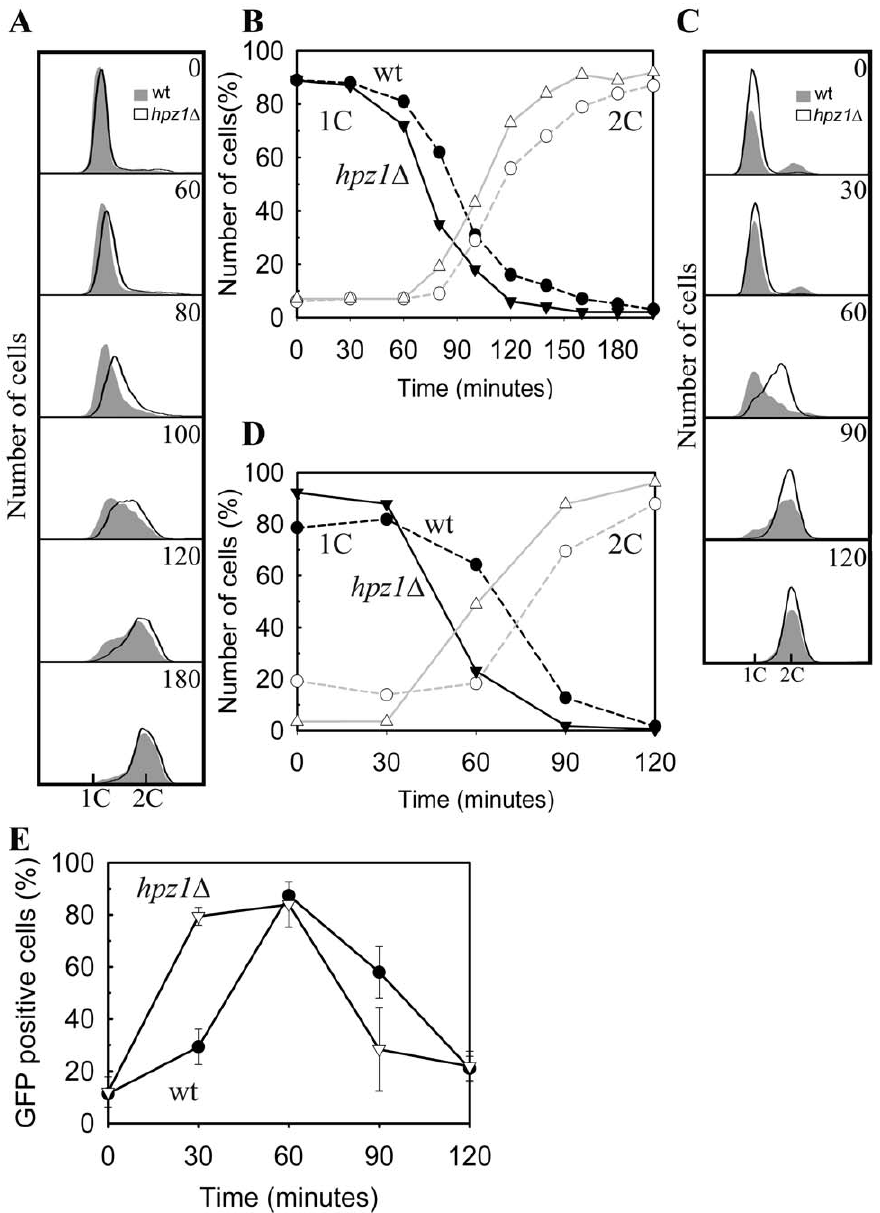
Figure 3. Progression of DNA replication. Analysis of the increase in DNA content in individual wild-type and hpz1 D cells after two different methods for synchronization and release. A. DNA histograms of cells blocked in early S phase by HU-treatment for 4 hours, then washed and released into the cell cycle for the times indicated. B. Quantification of the cells (in A) with a 1C DNA or 2C DNA content after HU-treatment and release into the cell cycle for the times indicated. C. DNA histograms of cdc10 cells that were synchronized in G1 phase, released into the cell cycle and incubated for the time indicated. D. Quantification of the cells (in panel C) with a 1C DNA or 2C DNA content after a cdc10 block and release into the cell cycle and incubated for the times indicated. E. PreRC formation in wild-type and hpz1 D cells as a function of time after release from a cdc10